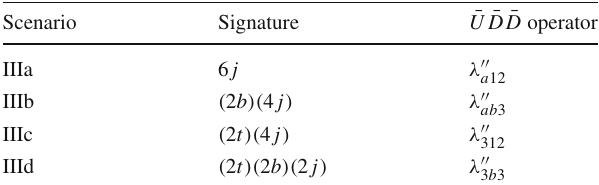
Table 7 Possible final states in the ¯ U ¯ D ¯ D case for a pair of neutralino LSPs decaying via the same operator. There will be further accom- panying particles from the cascade decay of the originally produced particles, e.g. for squark pair production ˜ q ˜ q ∗ → q ¯ q ˜ χ 0 extra jets. The indices a , b = 1 , 2 denote quarks from the first or